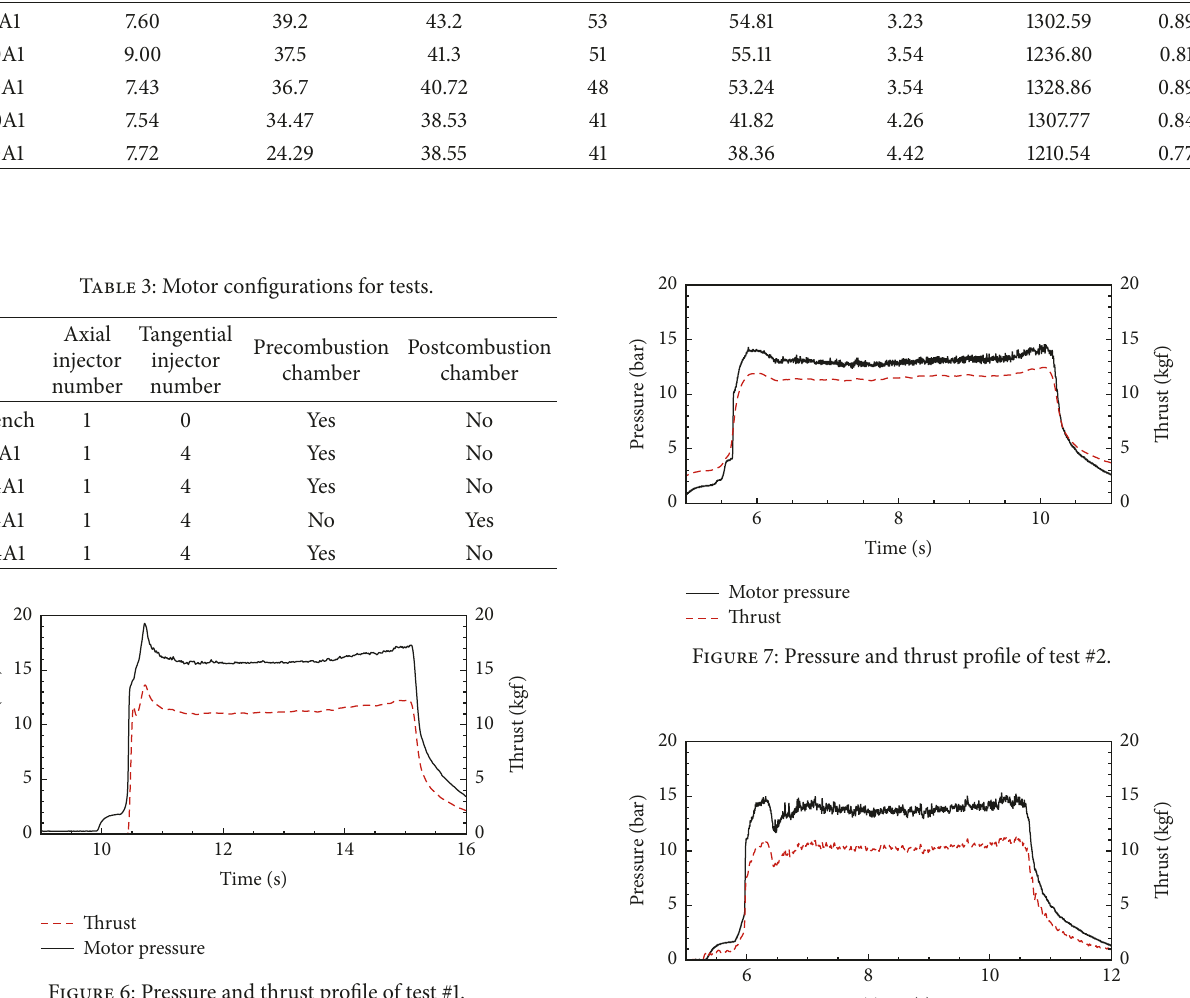
Figure 6: Pressure and thrust profile of test #1.